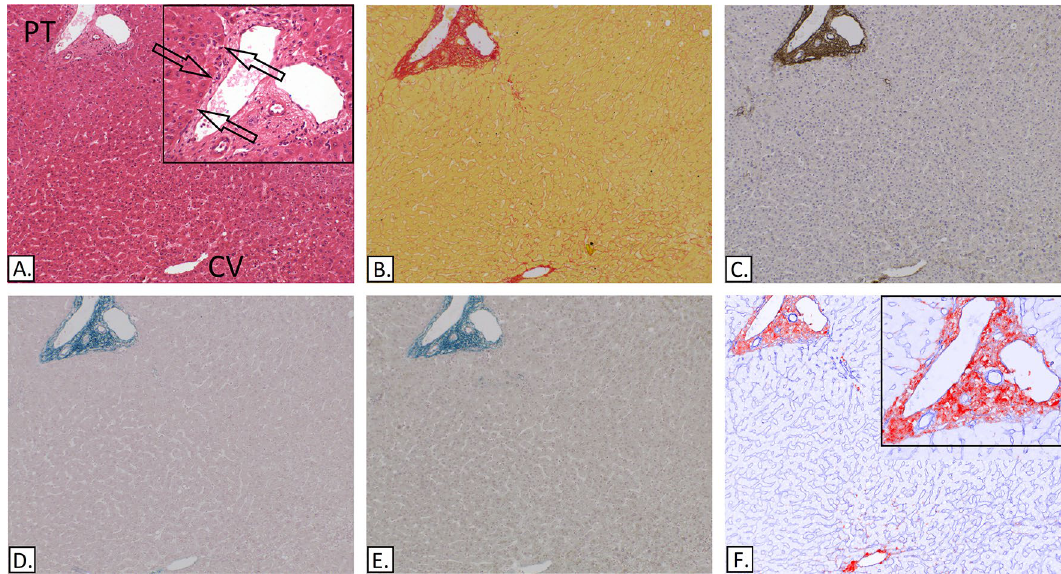
Figure 1. Demonstration of the 6 techniques used and their localization in normal liver showing the centrilobular hepatic venule (CV) to portal tract (PT) axis. The arrows mark the limiting plate. ( A ) H&E. ( B ) Picro-Sirius red. ( C ) IHC-Elastin, (ab9519). ( D ) Victoria Blue. ( E ) Modified Victoria blue—no oxidation step. ( F ) IHC-collagen I (ab6308) in red & collagen III (ab7778) in blue, spectrally unmixed channels from Nuance camera + software.